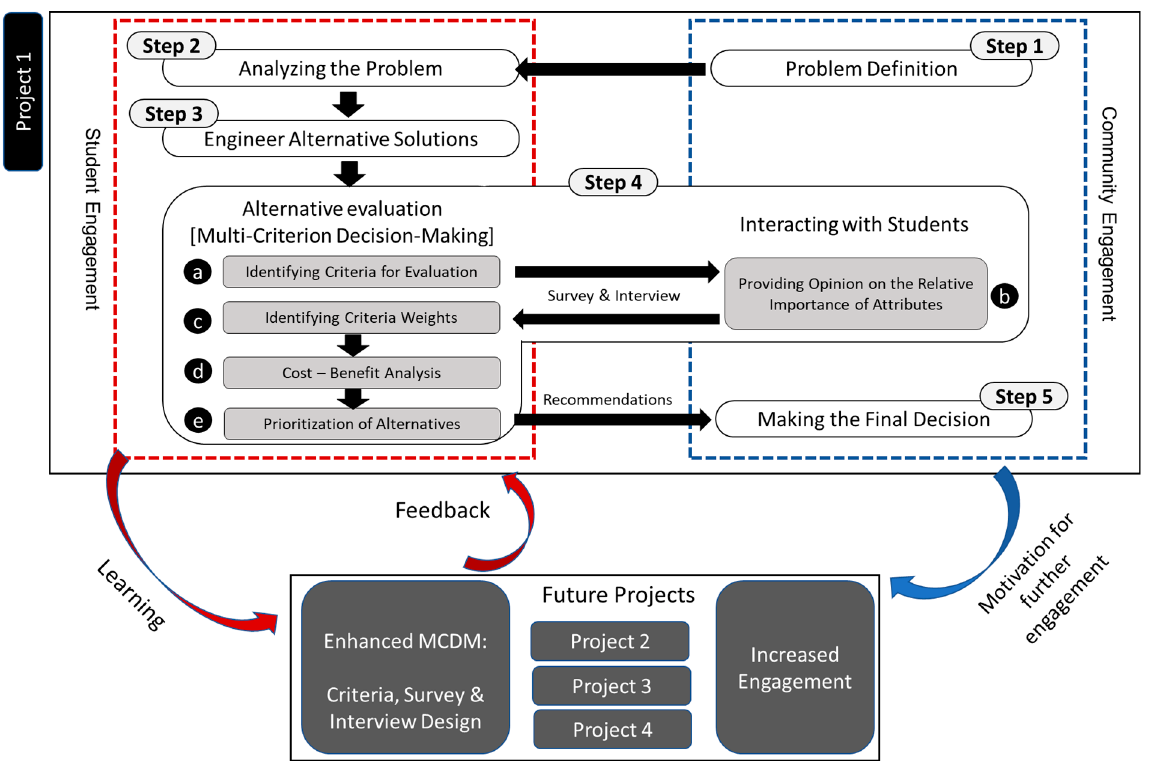
Figure 8. The proposed framework for engaging students with the stakeholders for infrastructure planning projects. planning